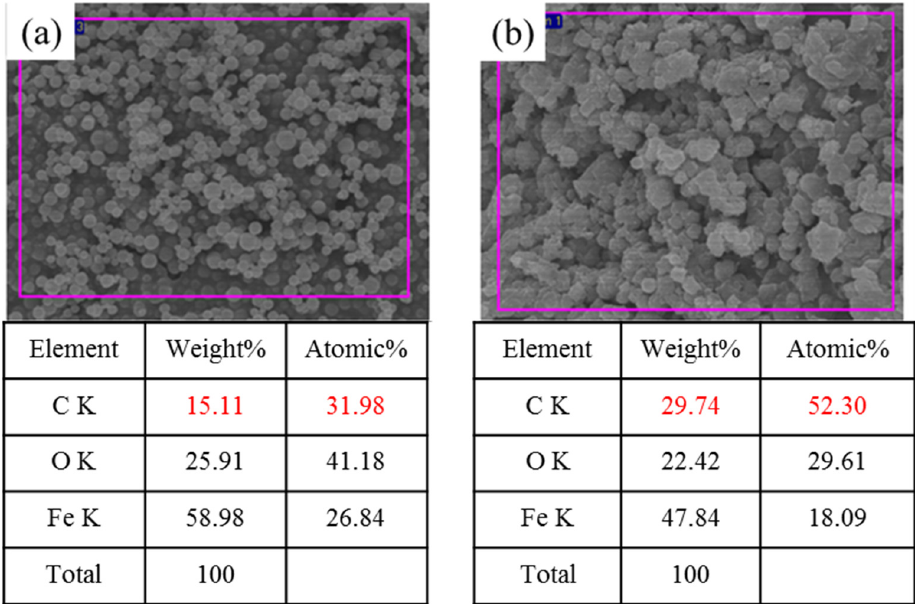
Figure 2. SEM images and EDS data of ( a ) the pure Fe 3 O 4 particles and ( b ) the Fe 3 O 4 /POA core–shell composite particles. Tables show the element information of the EDS spectra of the selected parts noted as pink squares in the corresponding SEM images for both types.